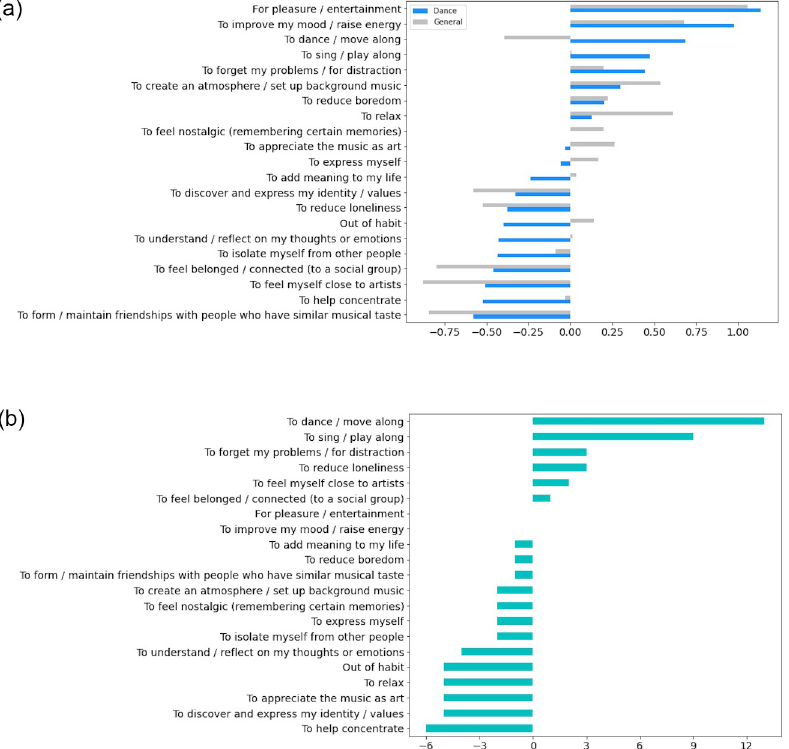
Fig 3. Z-scored distributions of ratings for RL dance and general . (a) Z-scored frequency distributions of ratings for RL dance (blue) and general (grey) are plotted. (b) Z-scored rank difference distribution for RL dance and general ratings. Rank scores of RL general items were subtracted from RL dance items.